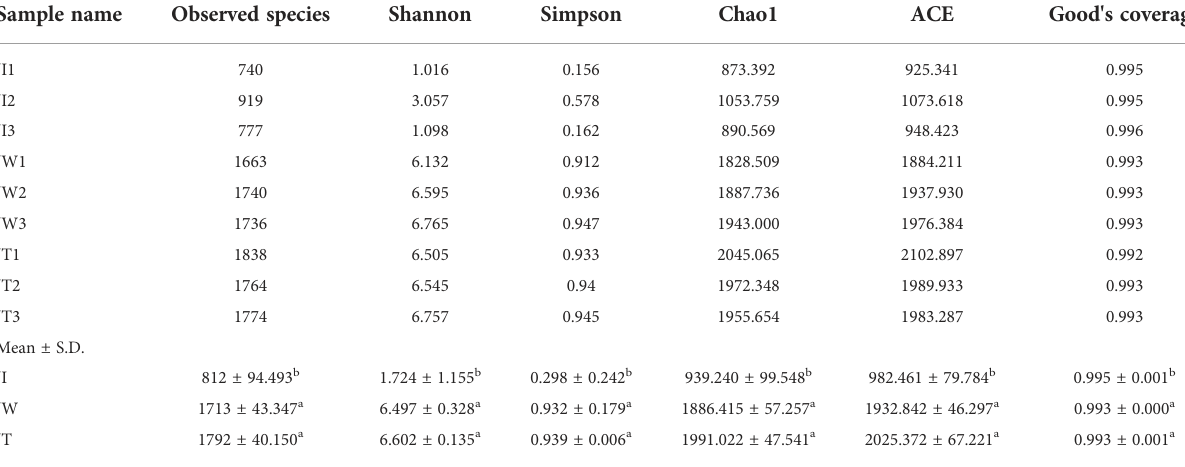
TABLE 3 Alpha diversity indices of shrimp intestine, water, and ef fl